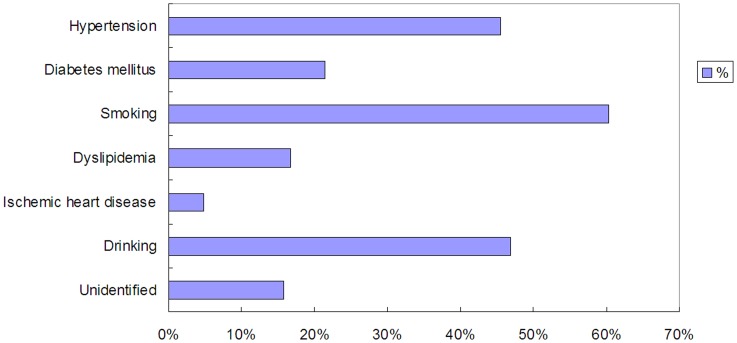
The distribution of risk factors in recruited patients.Risk factors include the history of the hypertension, diabetes mellitus, ischemic heart disease, dyslipidemia, smoking, drinking. For some patients, risk factors could not be identified.